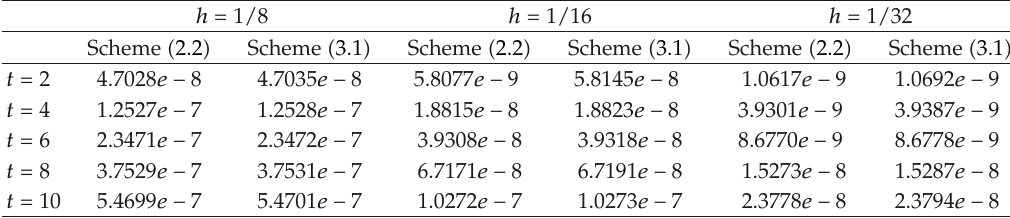
Table 1: The errors estimates in the sense of (cid:4) · (cid:4) ∞ , when p (cid:7) 2 and τ (cid:7) 0 . 1.